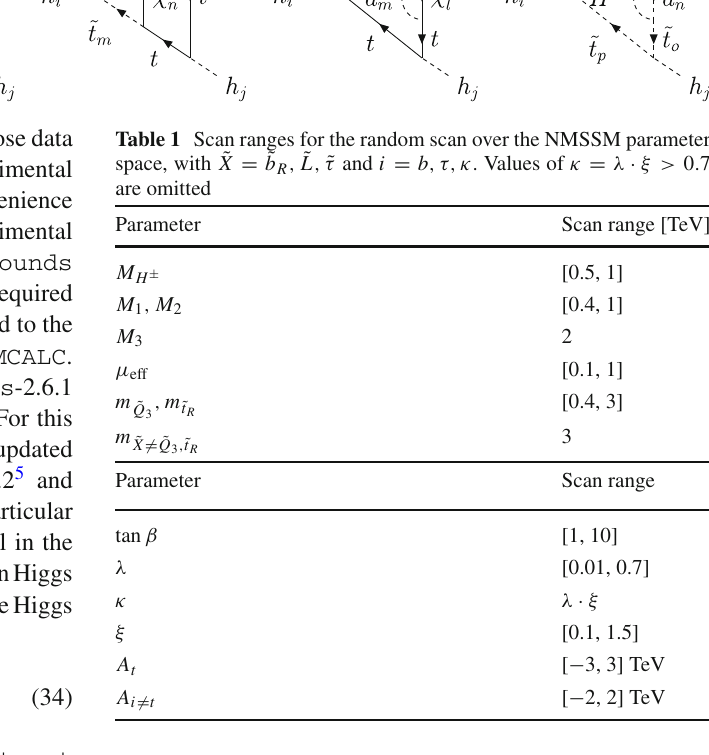
Fig. 1 Sample diagrams contributing to the trilinear Higgs self-coupling at O (α 2 t )